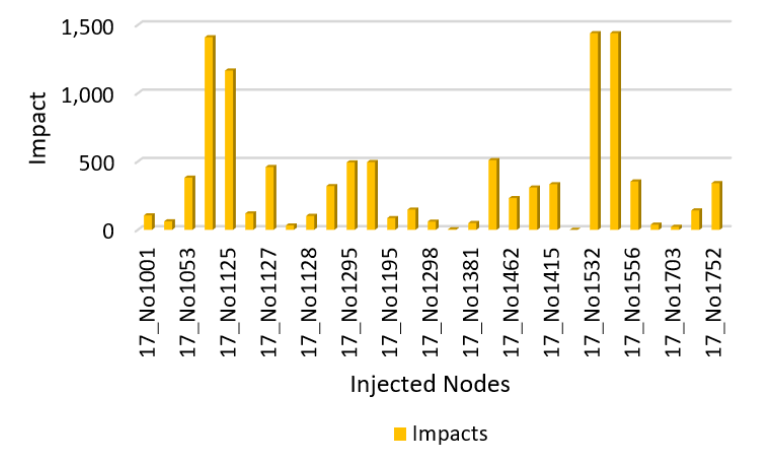
Figure 12. Health impact with 10 sensors deployed using time detection (TD).